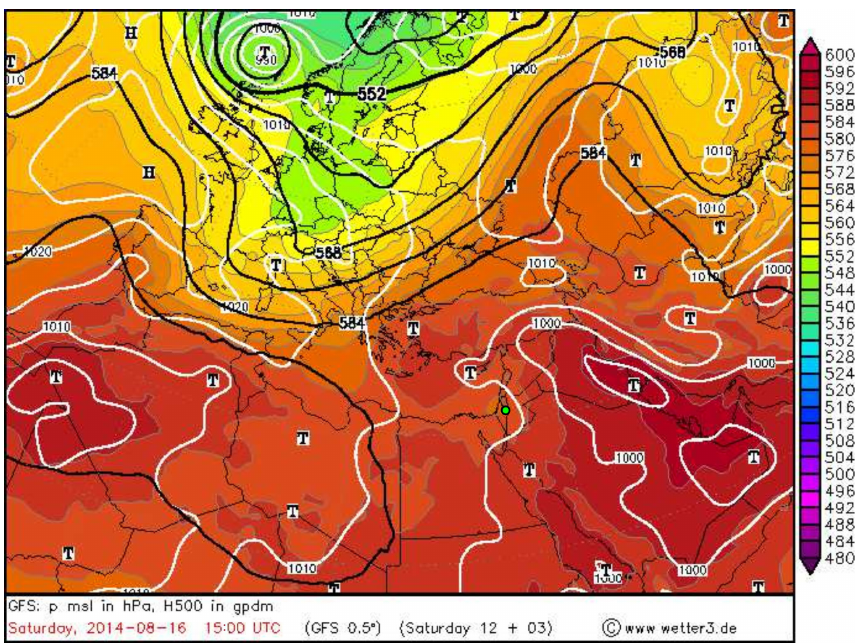
Figure 7. Large-scale synoptic conditions on 16 August 2014, 15:00UTC. Geopotential in gpdm at 500hPa (black contours), surface pressure in hPa (white contours), relative topography 500–1000hPa (coloured). Green dot indicates investigation